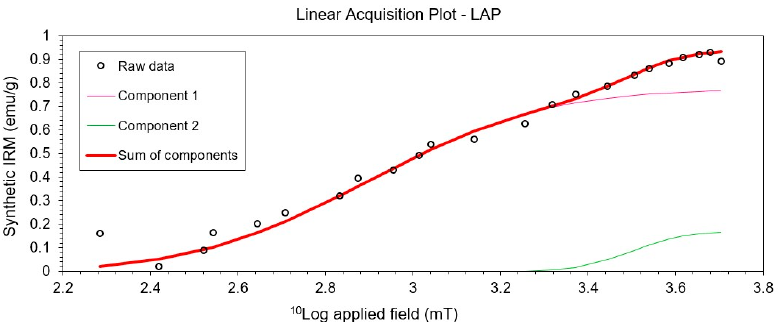
Figure 4. Analysis of the coercivity components of sample belongs to unit TD9 with the Kruiver approach. IRM acquisition curve and corresponding IRM components on a log-linear scale (LAP) where the circles represent measured data and the solid line the modelled